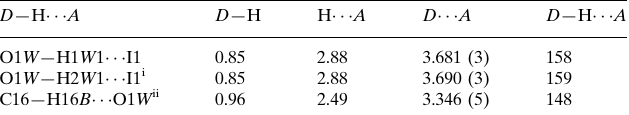
Hydrogen-bond geometry (A˚ , (cid:3)